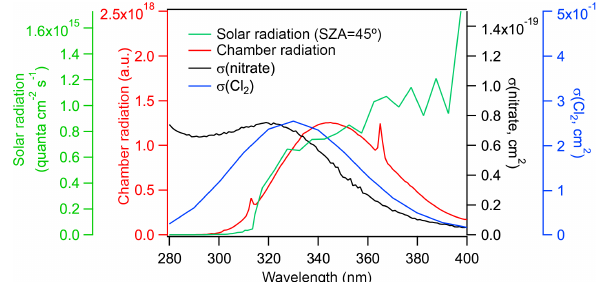
Figure 7. The radiation spectra of the chamber (red) and the sun (green, SZA = 45 ◦ as an example), and the absorption spectra of the nitrooxy enal (black, obtained in the liquid phase using acetonitrile solvent) and chlorine